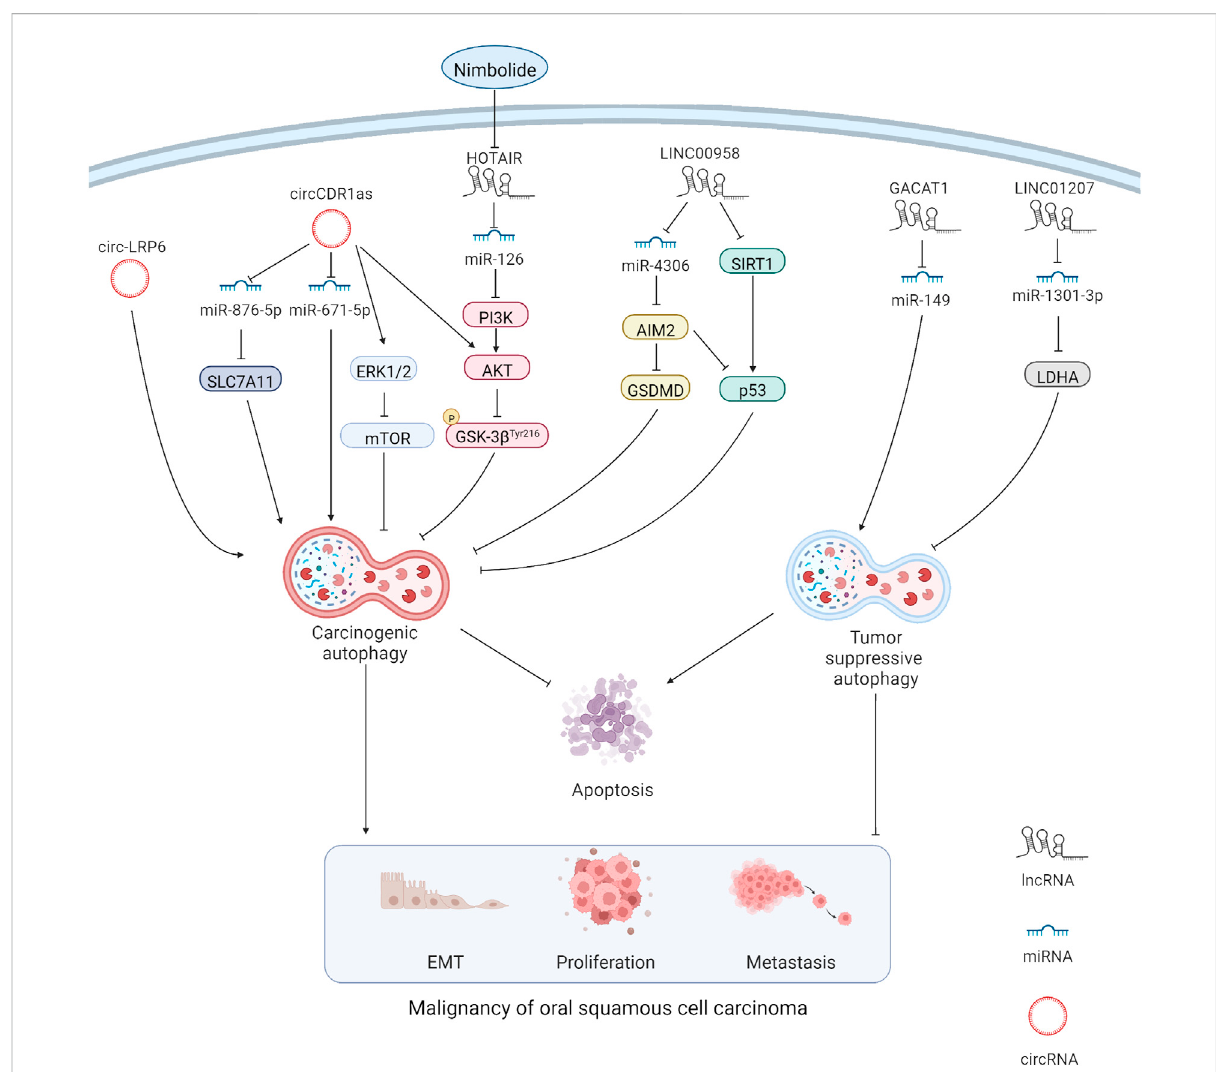
FIGURE 1 MiRNAs can directly interact with autophagy-related genes. At the same time, lncRNAs and circRNAs act as miRNA sponge through the mechanism of competitive endogenous RNAs, thus affecting the expression of miRNA target genes. Carcinogenic lncRNAs and circRNAs resist apoptosis and promote malignancy in OSCC cells by promoting carcinogenic autophagy and inhibiting tumor suppressive